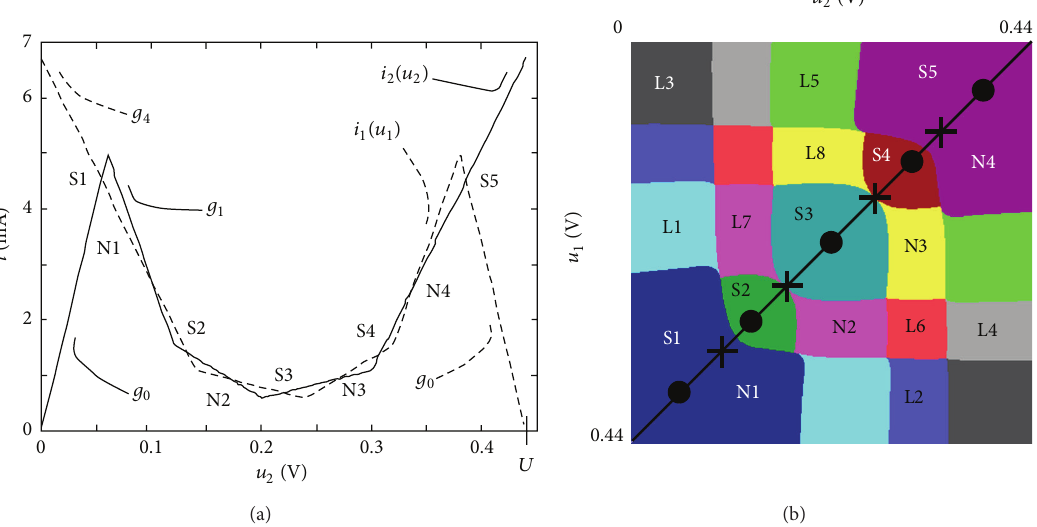
Figure 5: Projection of the I-V characteristics and depiction of the singular points into the plane 𝑖 , 𝑢 2 for 𝑅 = 0 Ω . Cross-sections of the BS in the plane 𝑢 2 , 𝑢 1 ; (b) N 2, N 3 𝑖 = 0.94 mA. Values of the parasitic elements considered in all simulations are 𝐿 = 1 ⋅ 10 −10 H and 𝐶 1 = 𝐶 2 = 2.6 ⋅ 10 −13